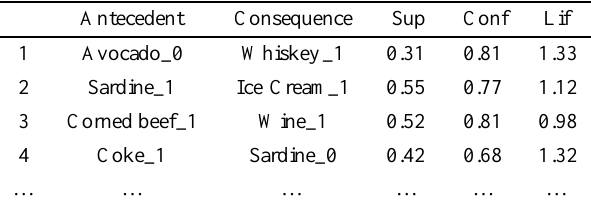
Table 7. Examples of excluded